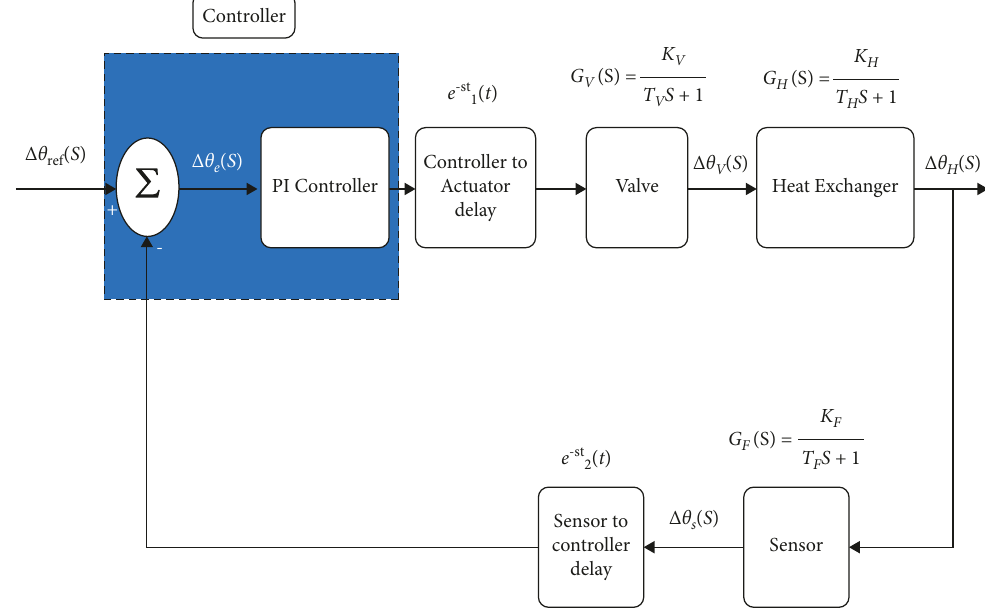
Figure 1: Illustration of a temperature closed-loop control system with various time